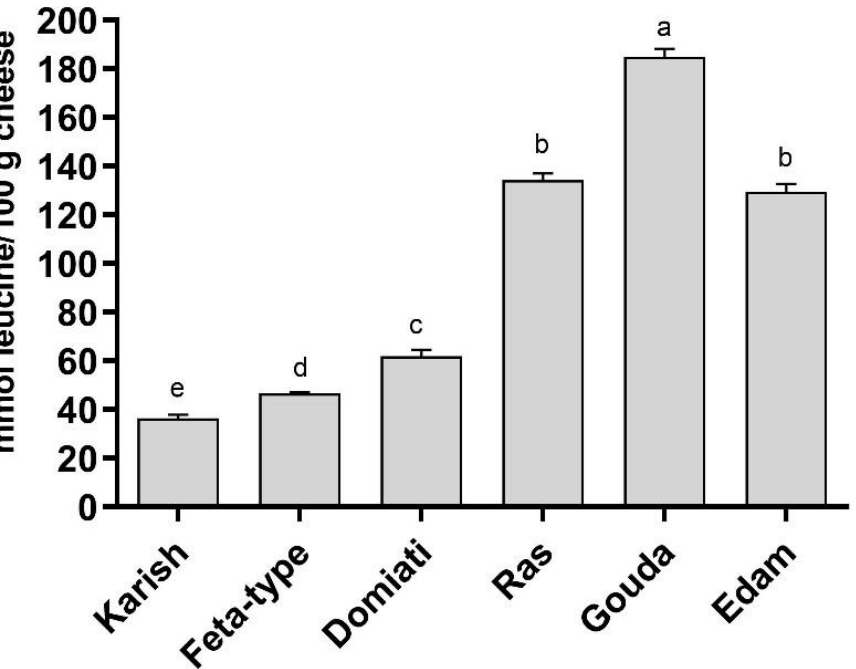
Figure 1. Total amount of low-molecular weight peptides (<3 kDa) in the different analysed cheese varieties. Values are the means of three assay replications ± standard deviation (SD). Different letters indicate significantly different values ( p < 0.05).